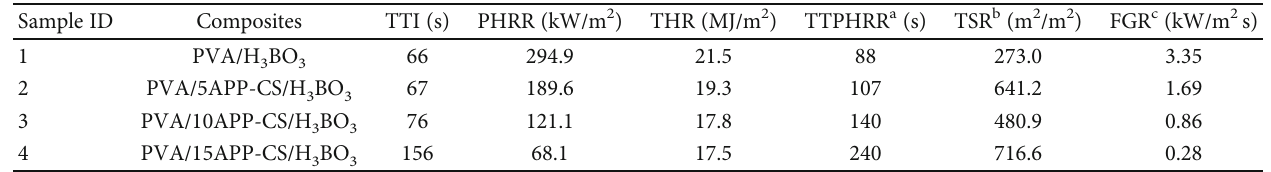
Figure 10: (a) Heat release rate (HRR), (b) total heat release rate (THR), and (c) CO Table 4: Combustion parameters obtained from cone calorimeter tests.